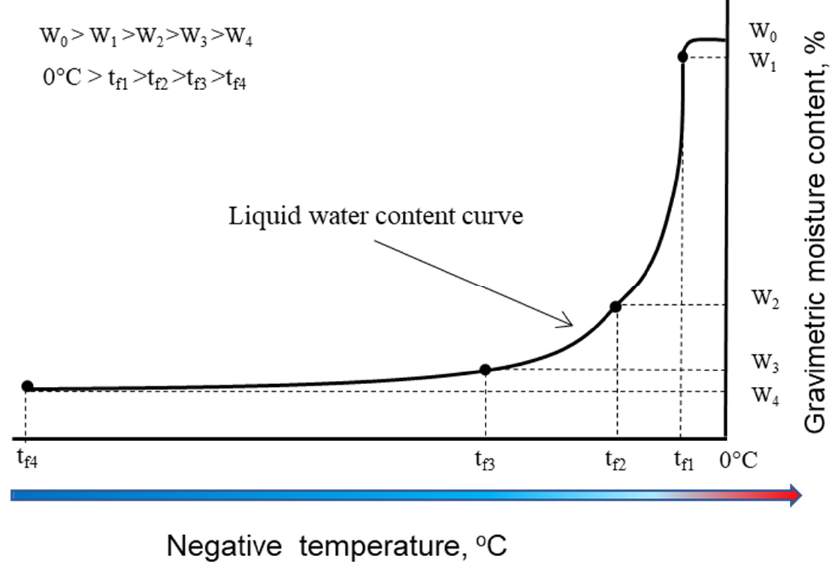
Figure 2. Temperature-dependent content of unfrozen pore water in permafrost. t f 1 , t f 2 , t f 3 and t f 4 are soil freezing points with moisture contents W 1 , W 2 , W 3 , W 4 , respectively. W 0 is the soil natural moisture content.